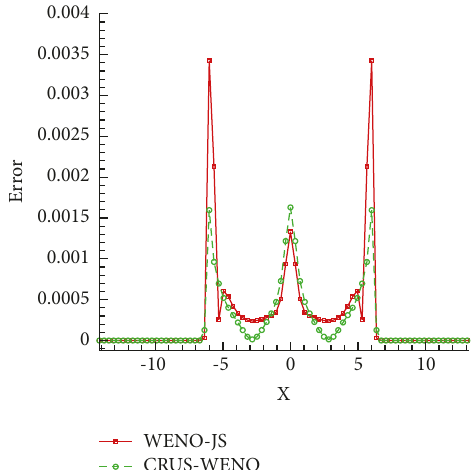
Figure 9: Example 7. Riemann problem. Errors of WENO-JS scheme and CRUS-WENO scheme with 200 × 200 grid points along x + y � 0. T � 0.5. The reference solution is computed by WENO-JS scheme with 800 × 800 grid